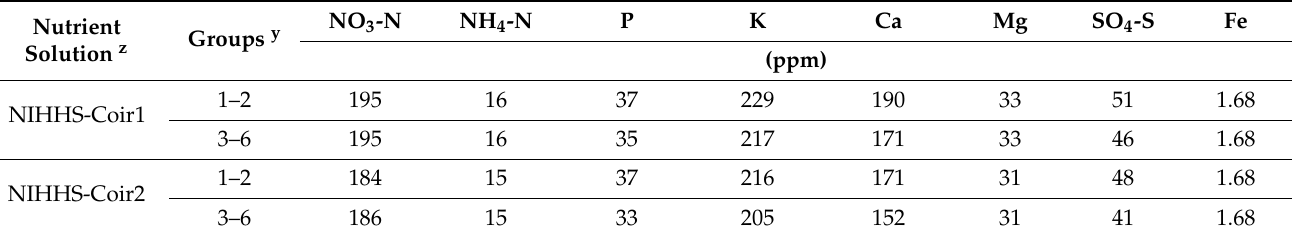
Table 2. NIHHS-Coir1 and NIHHS-Coir2 nutrient solutions used in the experiment to assess the suitability of newly formulated ion ratios for paprika plants in the closed hydroponic system with a coir